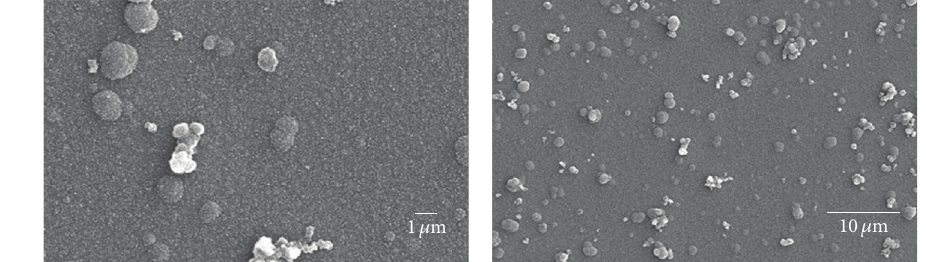
Figure 2: SEM images of PPy-IC-Ag nanop film.